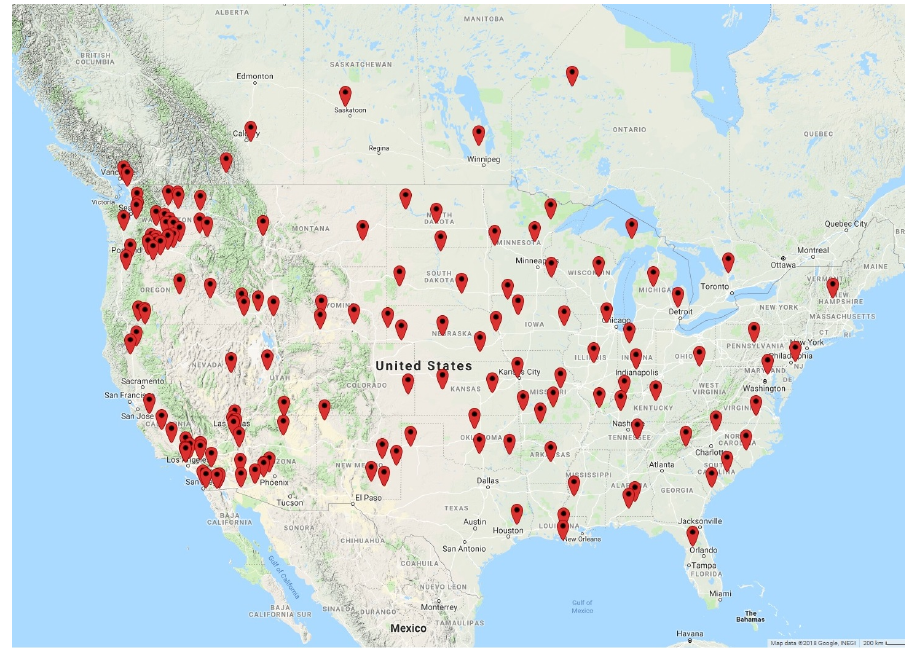
Figure 3. Locations of the 169